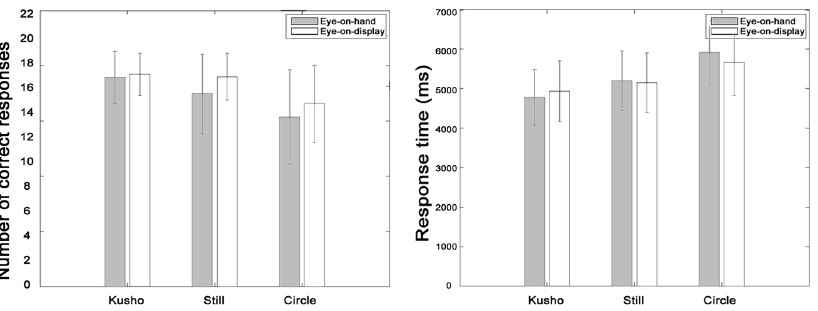
Fig 6. Correct response and response time in the stroke count task. The error bar indicates standard deviation. CR and RT of all hand conditions significantly differed from each other. There was no significant difference between the visual